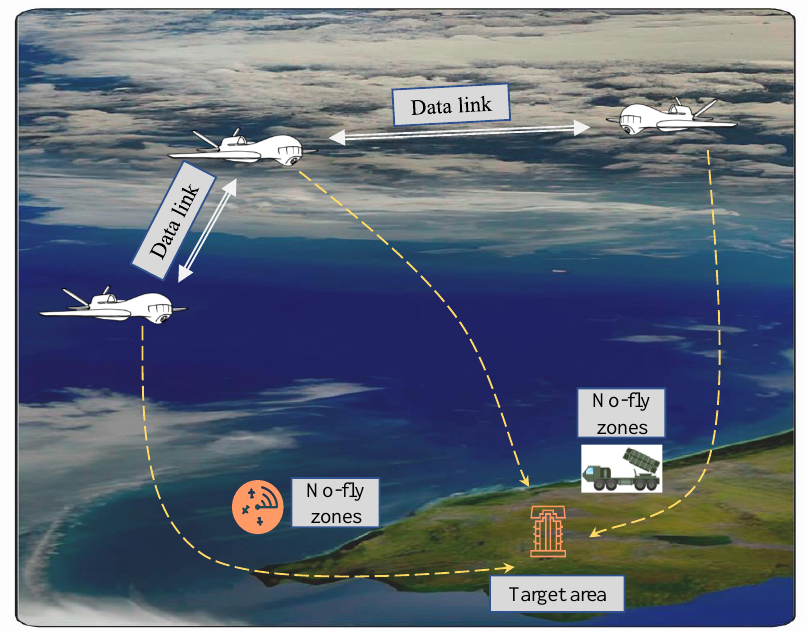
Figure 6. Cooperative reconnaissance-strike